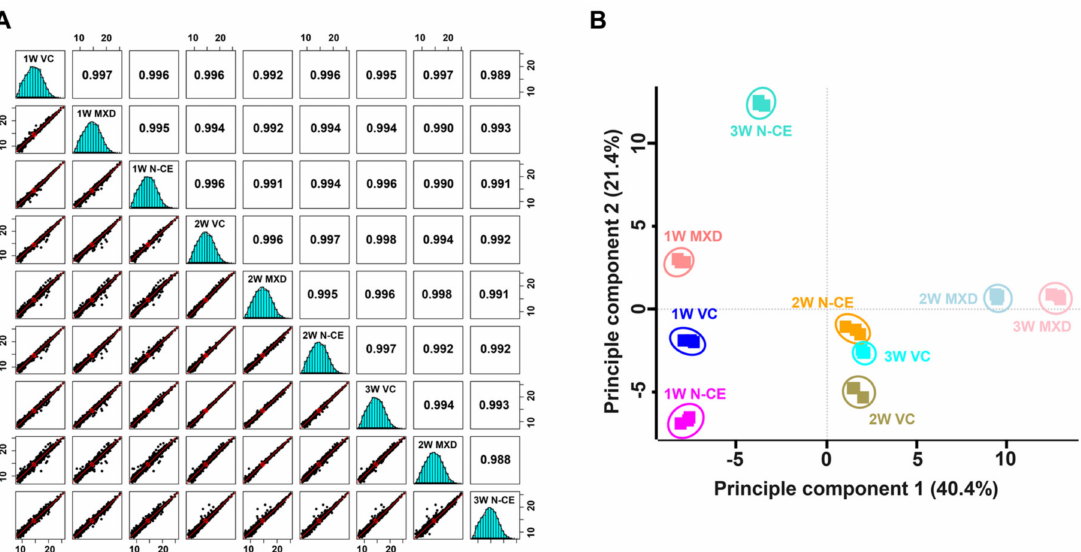
Figure 5. ( A ) Multi-scatter plot indicating the correlation between protein intensities among MXD and N-CE groups sample sets. Reproducibility across the replicate of three samples was revealed by Pearson’s correlation value. ( B ) Principle component analysis of significantly modulated proteins was identified by TMT-based quantitative proteome